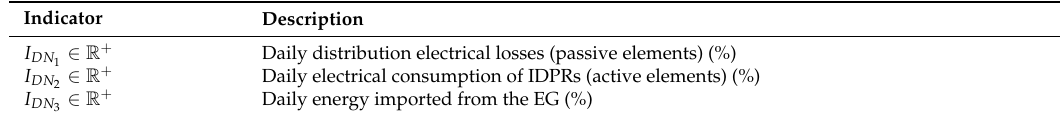
Table 19. DN related metricss ( I DN